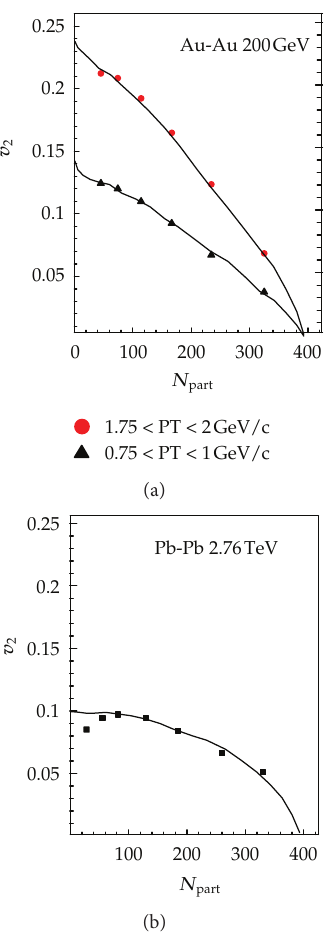
Figure 3: Dependences of 𝑣 2 on 𝑁 in √𝑠 𝑁𝑁 = 200 GeV Au- part Au collisions and √𝑠 𝑁𝑁 = 2.76 TeV Pb-Pb collisions. Experimental data taken from the PHENIX Collaboration [20] and the ALICE Collaboration [26] are shown with the scattered symbols. The curves are our calculated results. The error bars are smaller than the size of the data